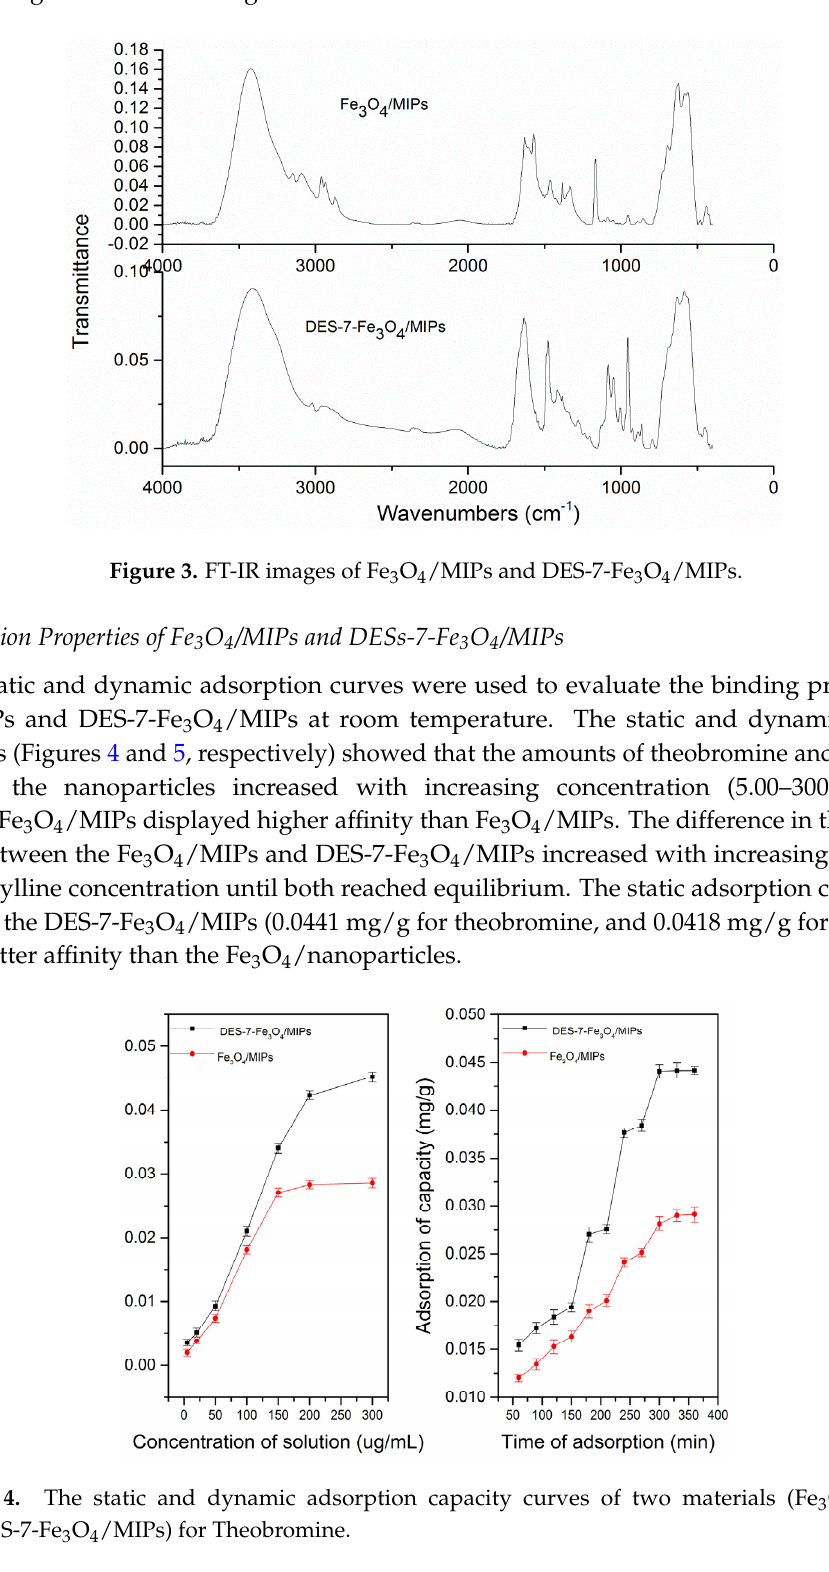
Figure 4. The static and dynamic adsorption capacity curves of two materials (Fe 3 O 4 /MIPs, and DES-7-Fe 3 O 4 /MIPs) for Theobromine.